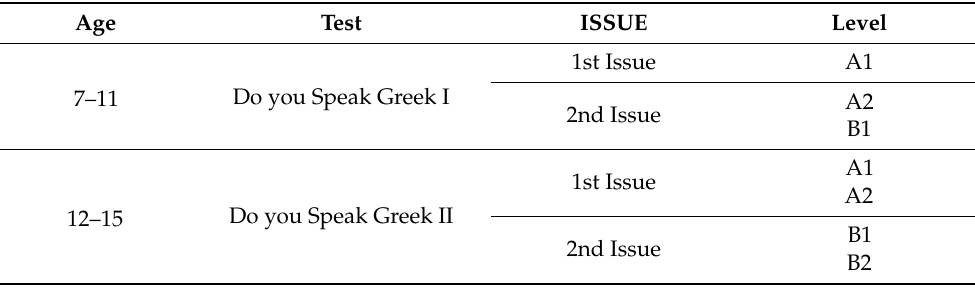
Table 3. Correspondence of tests, ages, and language level competence (as presented in the Guidelines for Use: http://iep.edu.gr/diapolitismiki/, accessed on 5 march 2022).